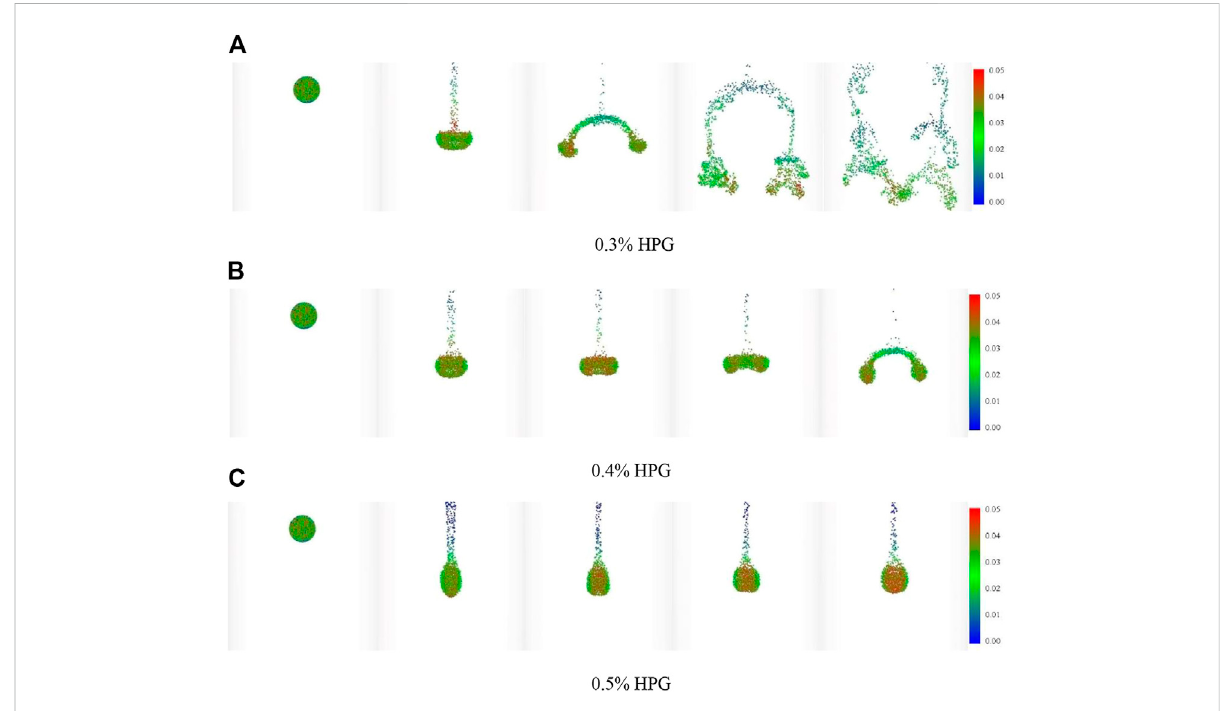
FIGURE 7 Particle velocity inside the cluster in HPG (N = 5,000). (A) 0.3% HPG, (B) 0.4% HPG, (C) 0.5%